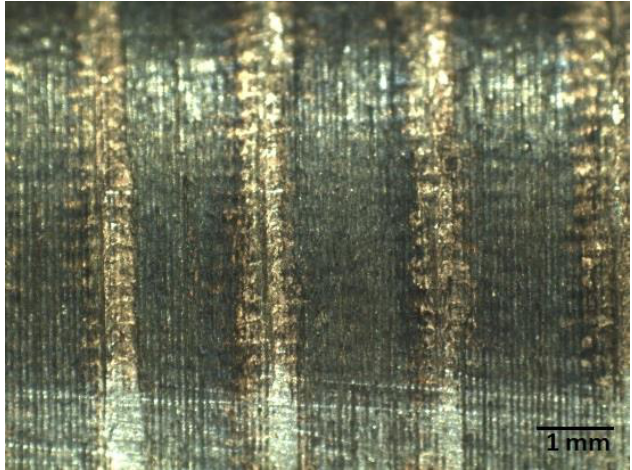
Figure 2. Regular microrelief with oil pockets to hold the grease in the process of friction—the study